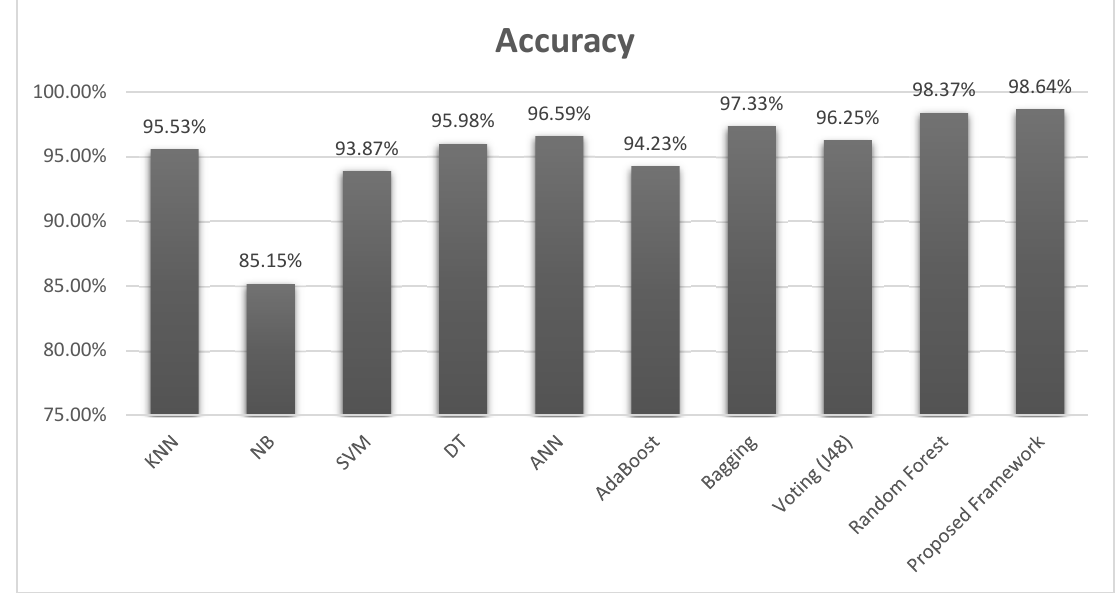
Fig. 7. The Accuracy of the Ensemble